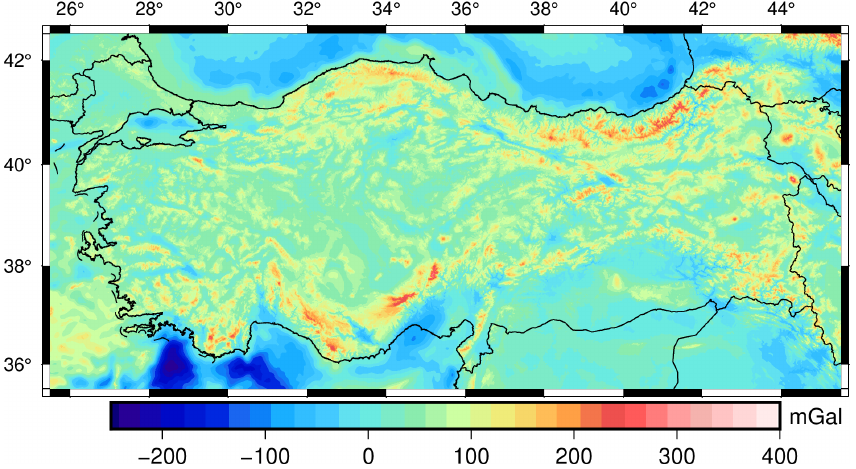
Figure 2. Free-air anomaly grid used in this study ( Min = − 236.2 mGal, Max = 300.8 mGal, Mean = 35.1 mGal, SD = 55.6